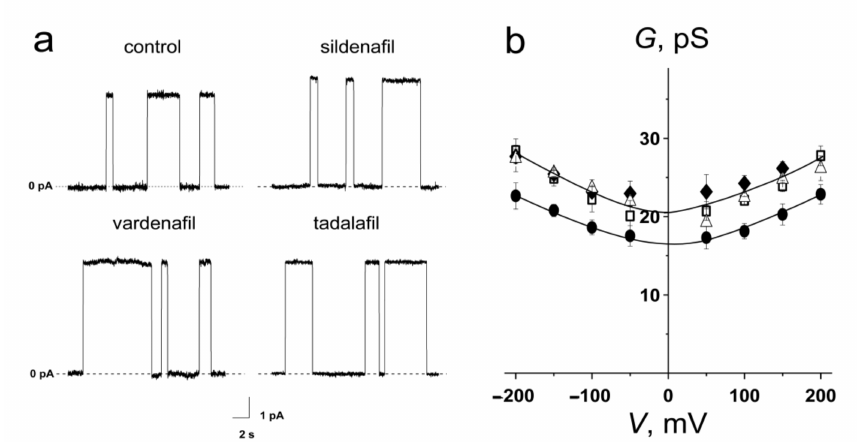
Figure 2. ( a ) Current fluctuations corresponding to openings and closures of single GrA channels in the absence (control) and presence of 100 µ M of sildenafil, vardenafil, and tadalafil ( V = 200 mV). ( b ) G–V curves of single GrA in the absence ( • ) and presence of 100 µ M of sildenafil ( (cid:3) ), vardenafil ( ∆ ), and tadalafil ( (cid:7) ). The membranes were composed of POPC and bathed in 2.0 M KCl (pH